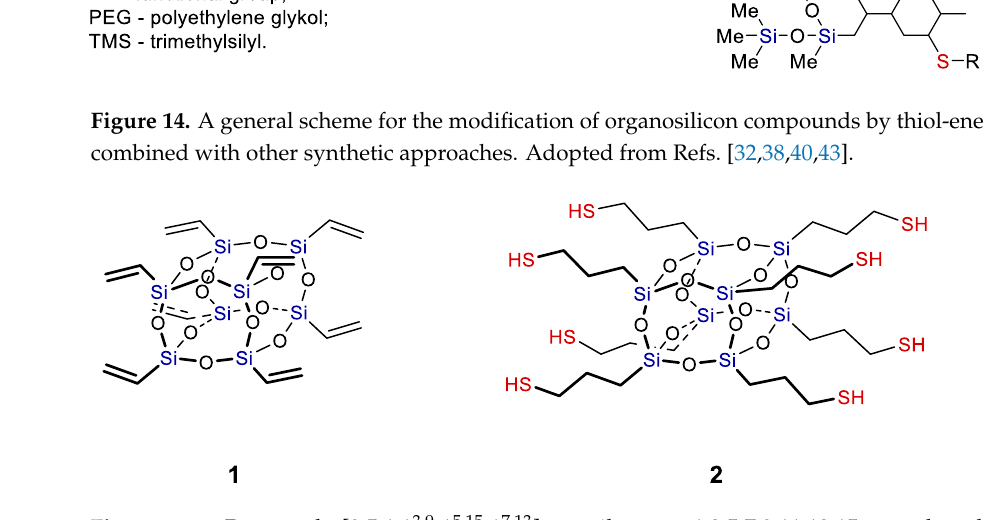
Figure 16. The hydrosilylation of hydrodimethyl-silylated oligomethylsilsesquioxane (MSQ-SiH) and octavinyl polyhedral oligomeric silsesquioxane (Vinyl-POSS). Reprinted/adapted with permis- sion from Ref. [55]. Moreover, it should be mentioned that significant progress in the hydrosilylation of S, N-containing alkenes has been achieved [60]. However, the reported procedure requires a high Ir loading when compared to the typical Pt-hydrosilylation procedures. An efficient solution was found by Marciniec’s team [61] who used two reactions for the functionali- zation of polyhedron 1 , i.e., cross-metathesis and silylative coupling (Figure 17).